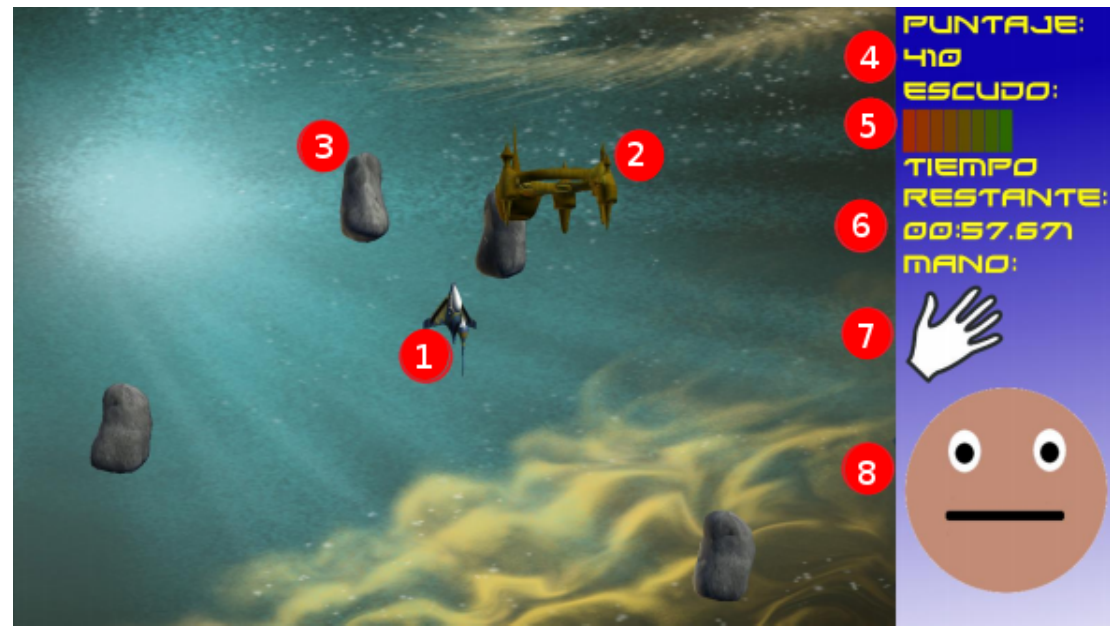
Figure 1. Graphical Items. (1) Spaceship; (2) Portal; (3) Asteroid; (4) Score; (5) Shield intensity (6) Timer